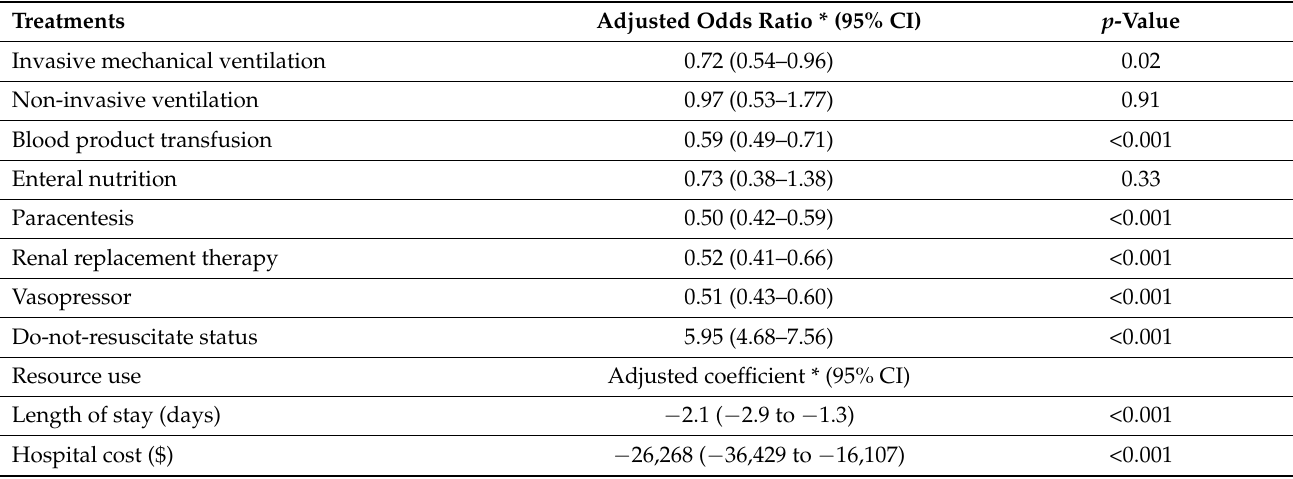
Table 4. The impact of inpatient palliative care service use on treatments and resource use in hospital admissions for hepatorenal